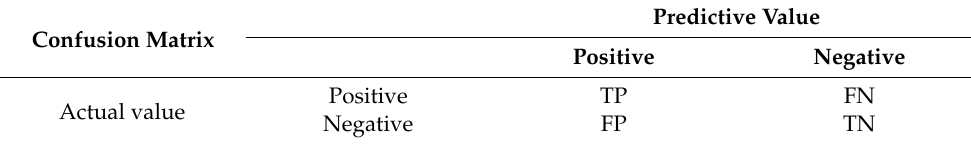
Table 2. Confusion matrix.